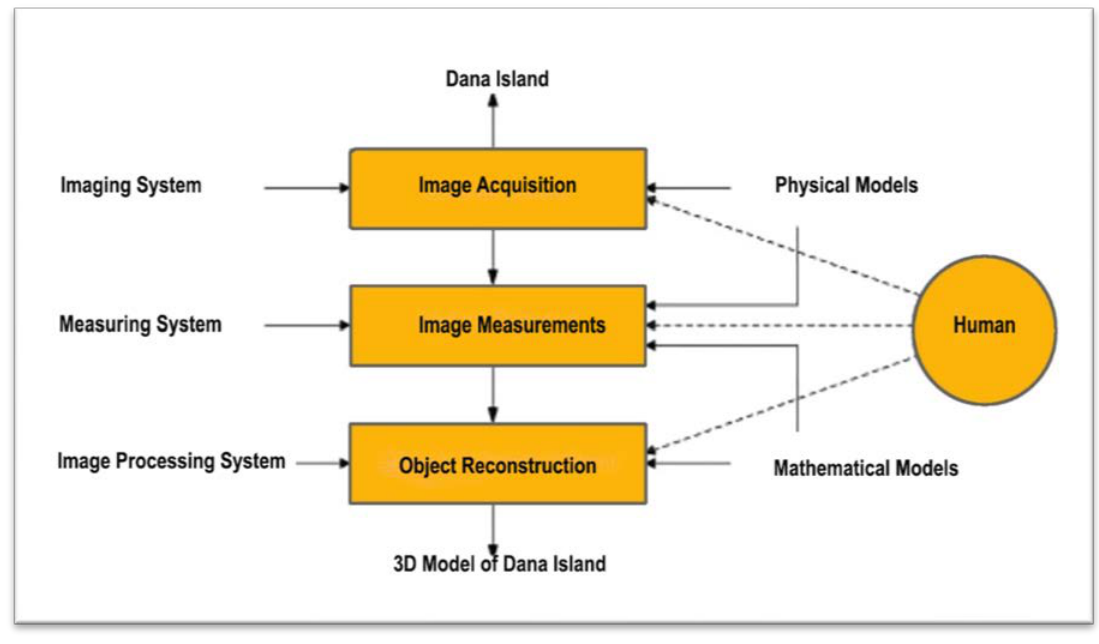
Figure 8 . Photogrammetric modelling workflow diagram